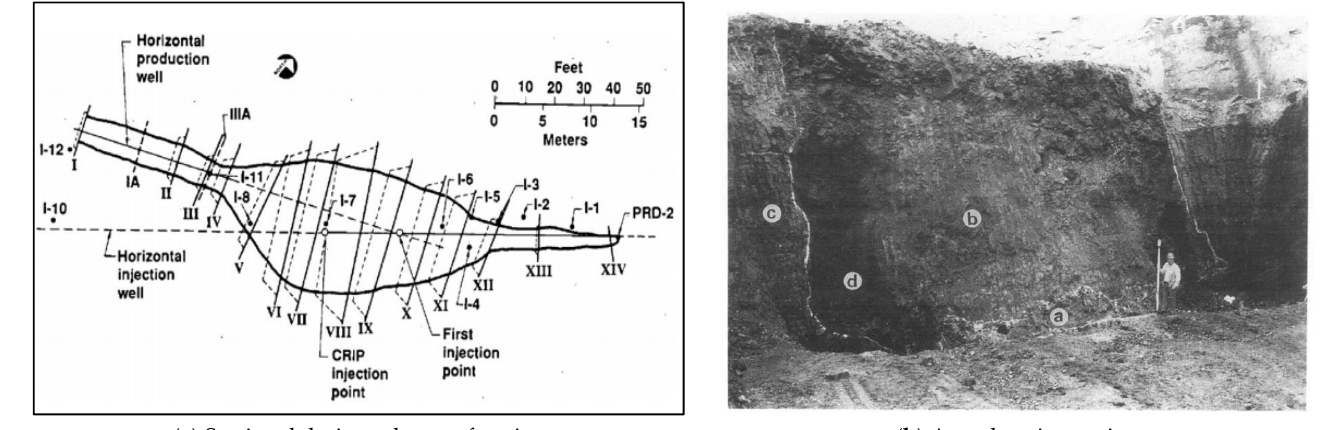
Figure 4. Cavity for large-scale CRIP-UCG trial at Centralia mine (from